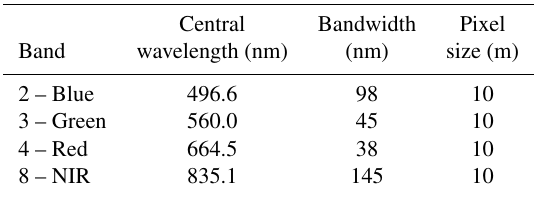
Table 1. Sentinel-2A bands in VIS and NIR used for linear spectral unmixing